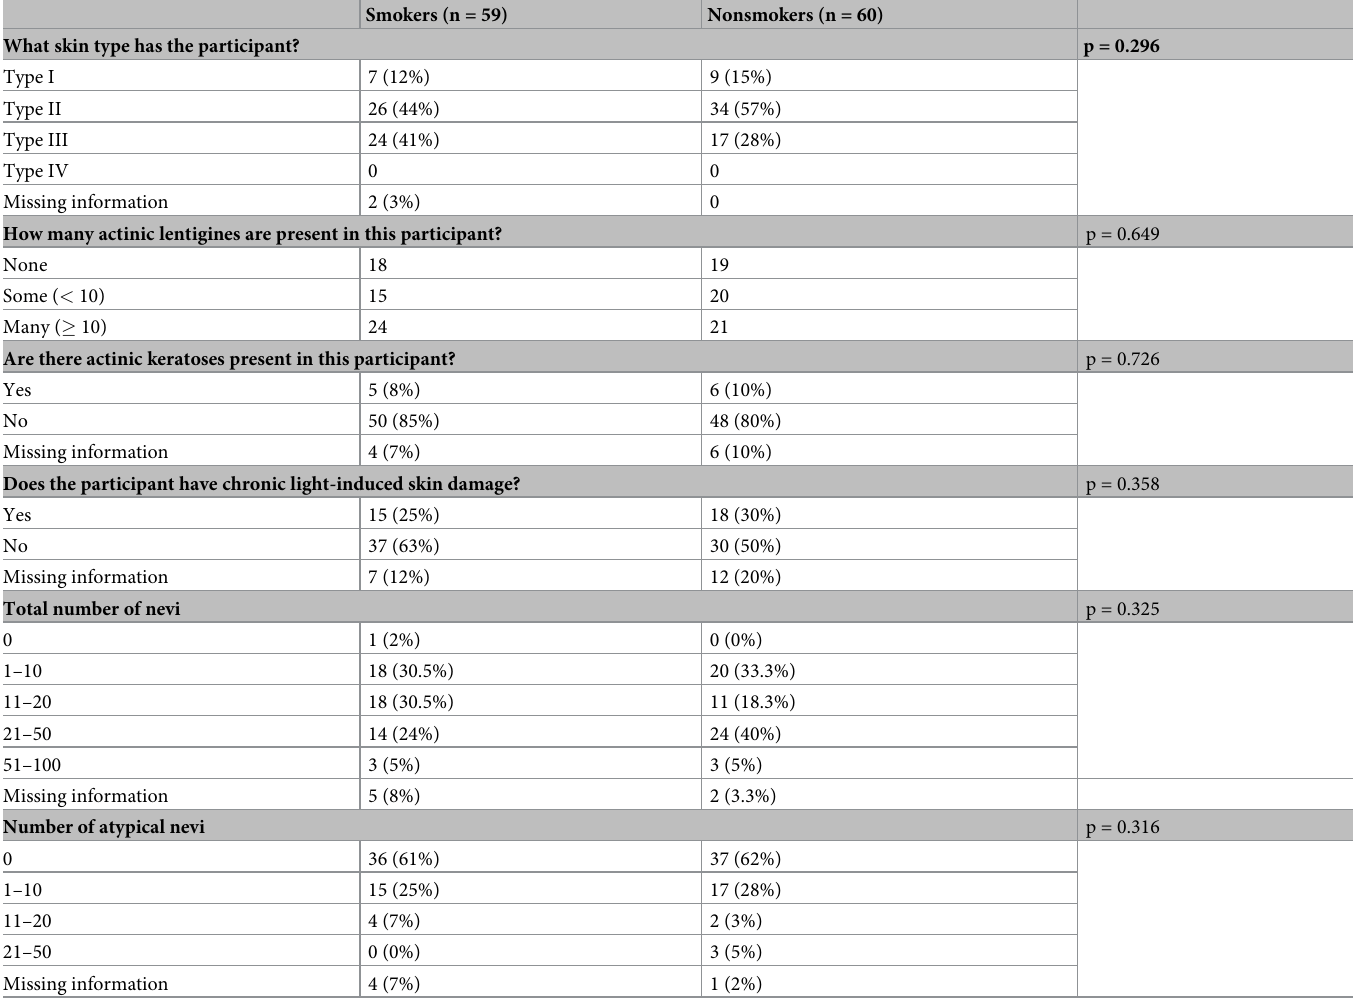
Table 3. Results of dermatological